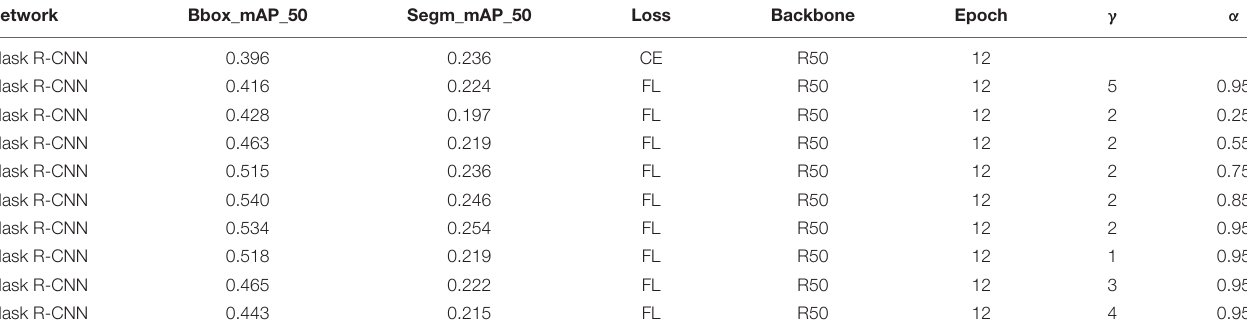
TABLE 2 | Training parameter and test results based on Mask R-CNN with different loss functions. Network